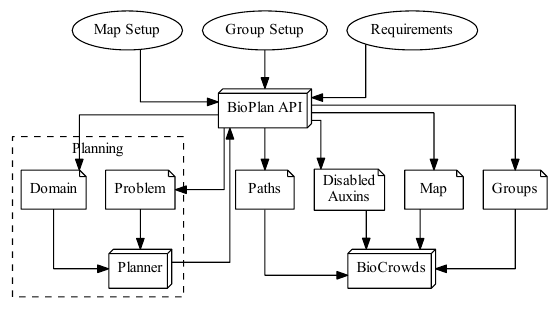
Fig. 2. Flow of the proposed